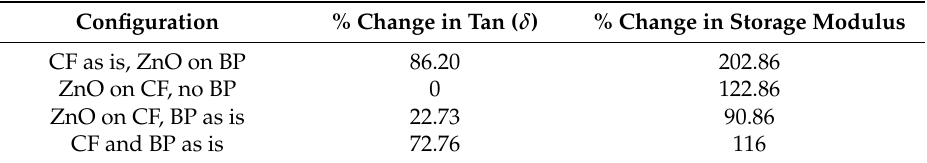
Figure 12. The variation of storage modulus with frequency at 30 °C for various configurations of two-layer composite samples. Table 3. Percentage change of tan delta (at 63 Hz) and storage modulus (independent of frequency) during frequency scan at 30 °C with respect to the composite based on CF only.